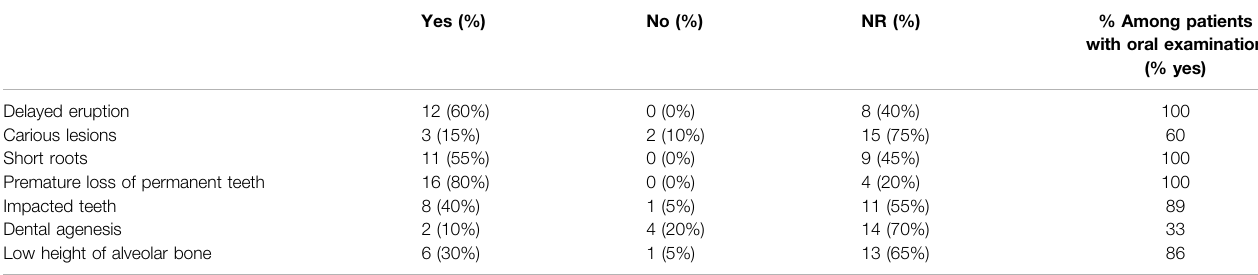
TABLE 3 | Oral and dental phenotypes of Singleton – Merten